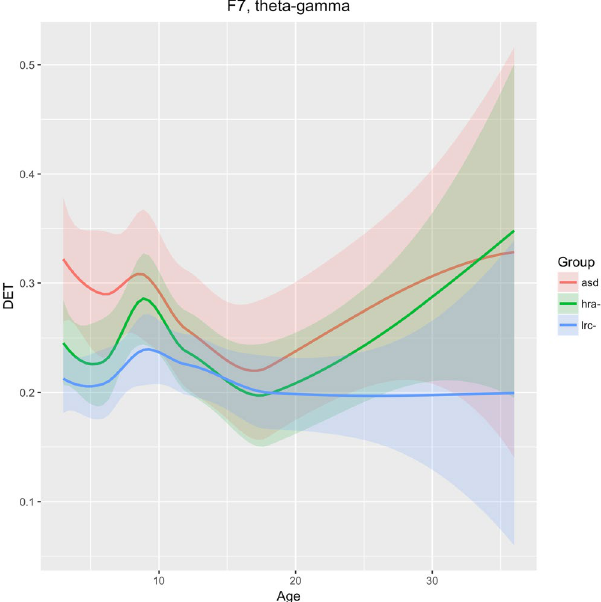
Figure 10. Developmental trajectories for DET in the left lateral-frontal region (F7 sensor) in frequencies theta through gamma for ASD, LRC − , and HRA − Right temporal-parietal. Figure 9 shows changes in sample entropy in the right temporal-parietal region (sensors T8, P4, P8). Frequencies in the theta, alpha, beta, and gamma bands were found to have similar trends and magnitudes, so are considered as a whole here. The sample entropy is similar in all three groups until 6 months, but then diverges significantly by 9 months and the groups continue to diverge through 36 months, maintaining con- sistent and significant differences. The ASD and LRC − groups are the farthest apart, with the HRA − group having values intermediate between the higher LRC − and the lower ASD entropy values. We note that the HRA − group appears to follow the ASD trend from 9 to 12 months, but then stops the downward trend of the ASD group and tends to normalize back toward the LRC − group, similar to the trajectory in T7 as seen in Fig. 8.